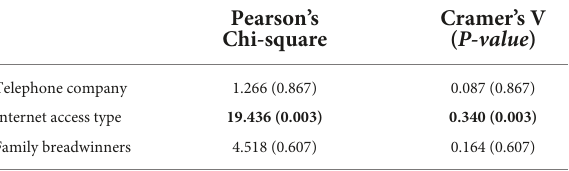
Cohen pearson ( P-value ) ( P-value